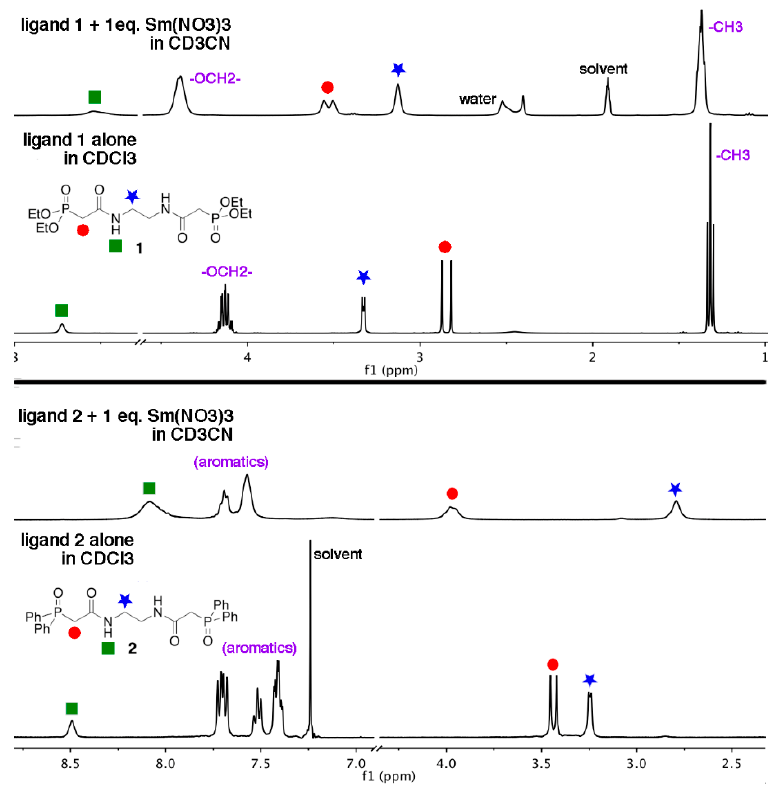
Figure 5. 1 H NMR spectra of ligands 1 and 2, along with their Sm(NO 3 ) 3 complexes. ( Top ): ligand 1 in CDCl 3 , and with 1 eq. Sm(NO 3 ) 3 in CD 3 CN. ( Bottom ): ligand 2 in CDCl 3 , and with 1 eq. Sm(NO 3 ) 3 in CD 3 CN. For all spectra, the key resonances have been labeled as: -N H (green square), -P-C H 2 -C- (red circle), -NH-C H 2 - (blue star).